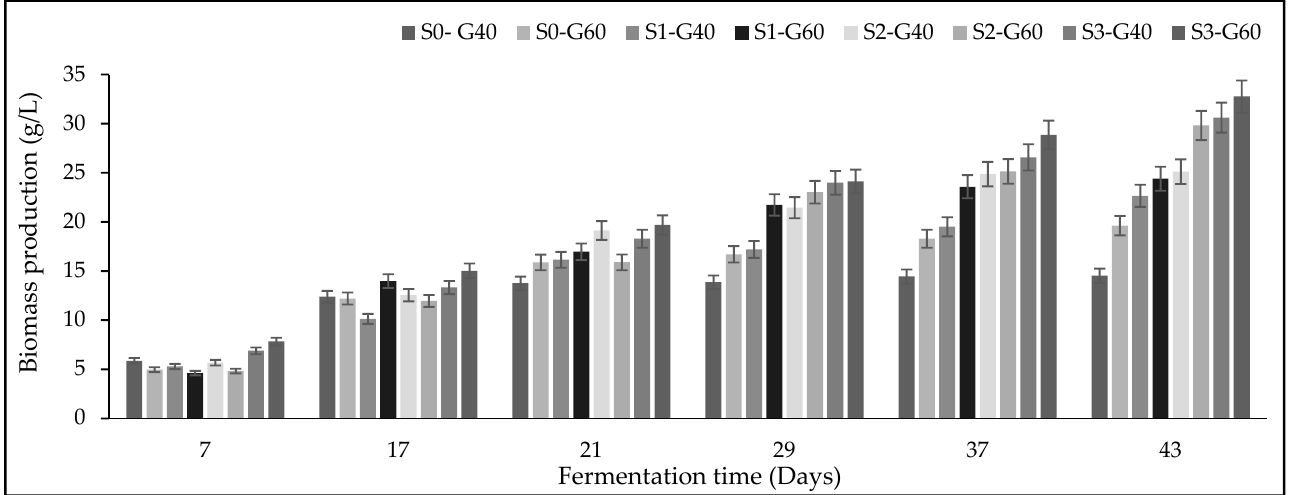
Figure 1. Biomass production (g/L) during the cultivation of P. pulmonarius in liquid cultures with OMWs containing 0, 1, 2 and 3 g/L phenolic compounds and initial concertation glucose 40 and 60 g/L (S0-G40, S1-G40, S2-G40, S3-G40, S0-G60, S1-G60, S2-G60, S3-G60, see Table 2). Each point is the mean value of at least three independent measurements, SD < 5%.